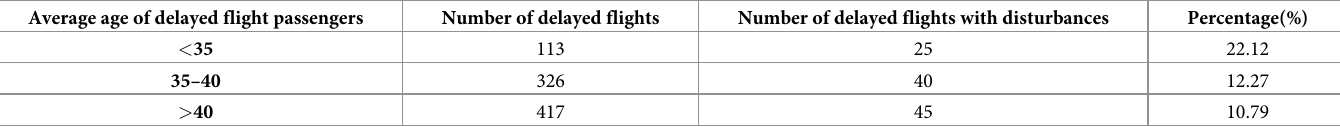
Table 5. Average age of delayed flight passengers and the number of flights with passenger disruptions at Shenzhen Airport, 2018. Average age of delayed flight